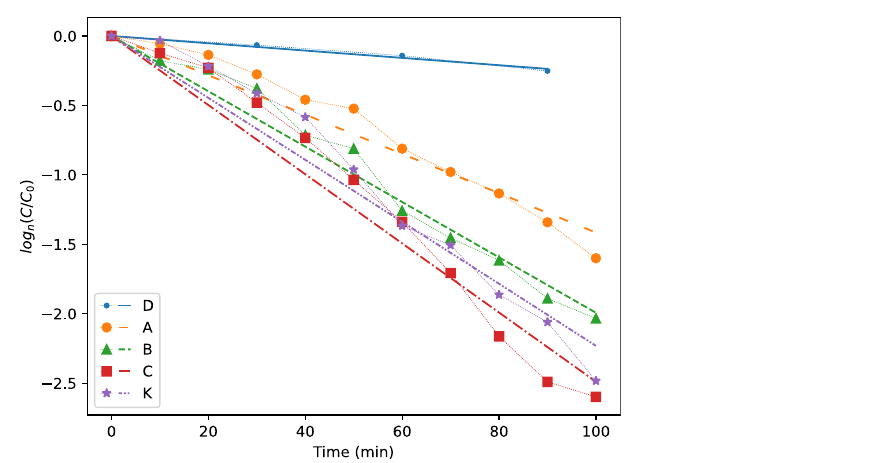
Figure 7 Reaction characteristics of the photodegradation of MB dye catalyzed by BTO samples (A), (B) and (C) depict logarithmic photodegradation. The control sample K has photodegradation characteristics similar to (B) and (C). The markers show experimental data, while the solid lines show straight line fi